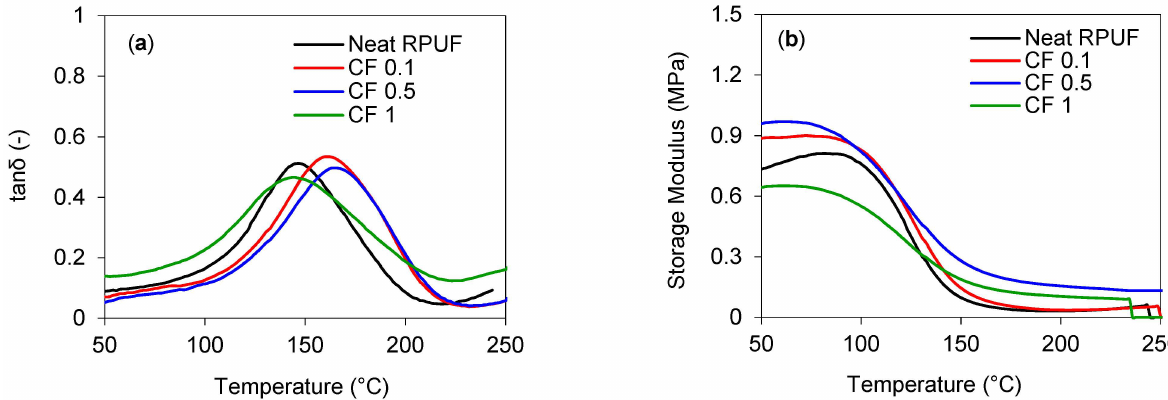
Figure 5. Dynamic mechanical analysis curves for the studied RPUF composites—( a ) tan δ and ( b ) storage